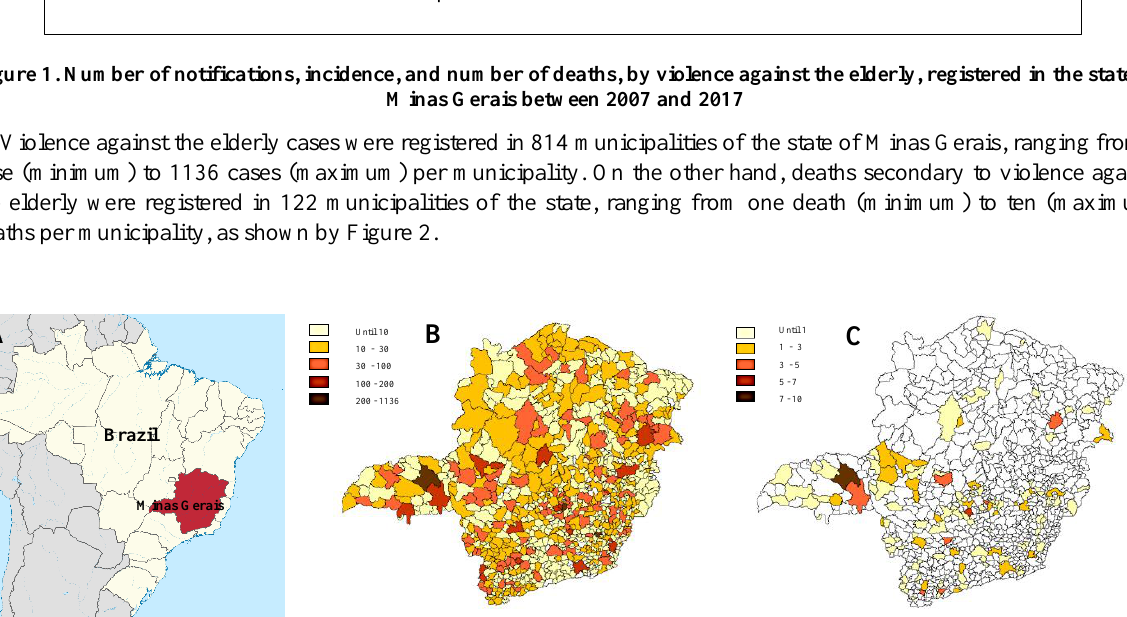
Figure 2. A. Geographic location of Brazil and the state of Minas Gerais. B. Spatial distribution of violence against the elderly cases according to the city of occurrence in Minas Gerais. C. Spatial distribution of deaths as a result of violence against the elderly according to the municipality of occurrence in Minas